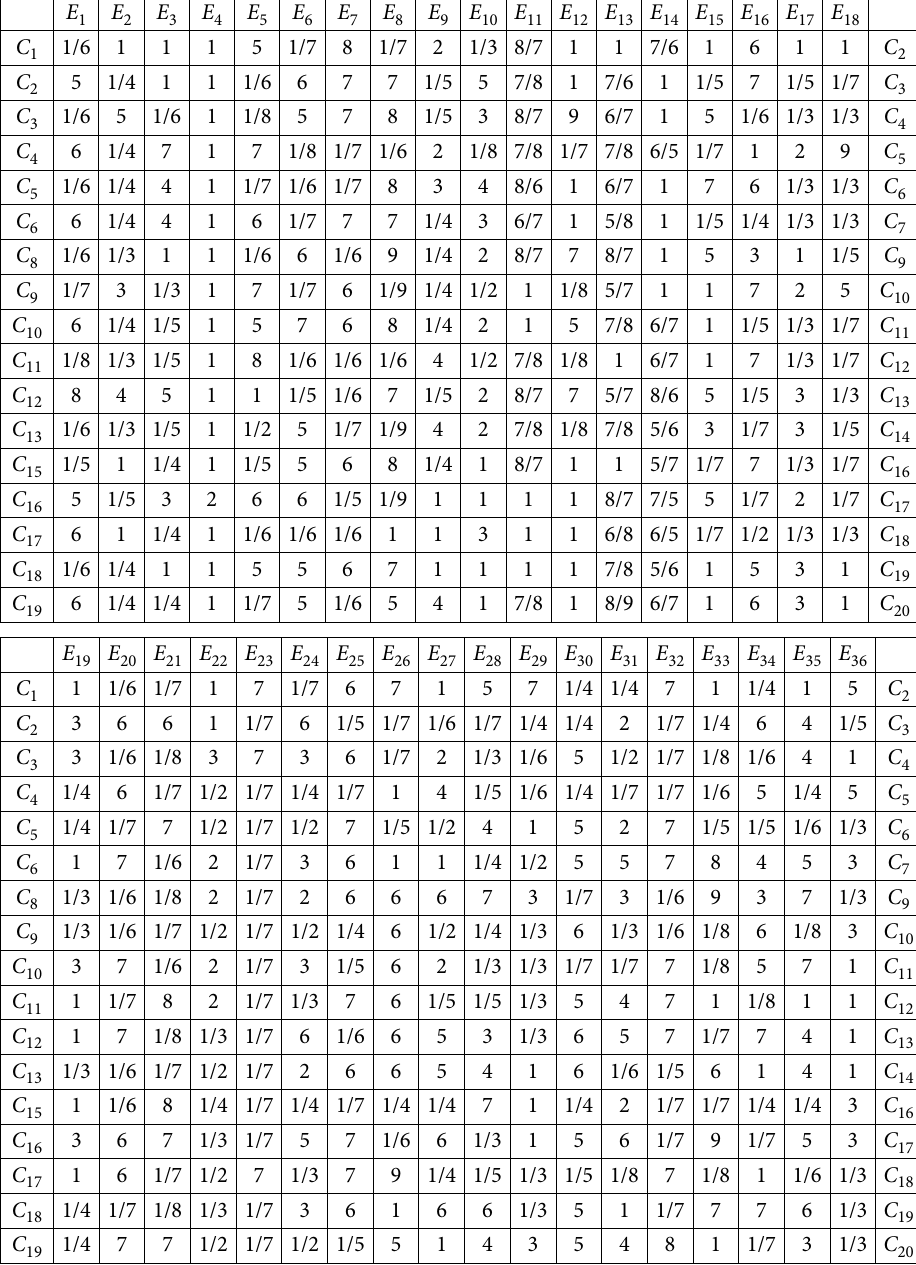
Table 2. Results of pairwise comparison in adjacent sequence for the criteria by